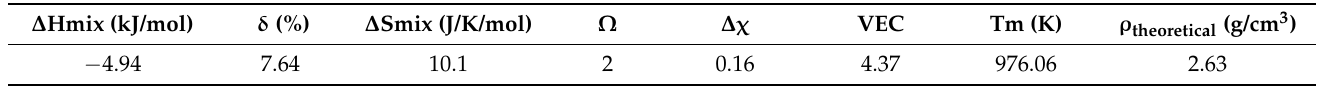
Table 2. Thermo-physical parameters and the theoretical density for the developed